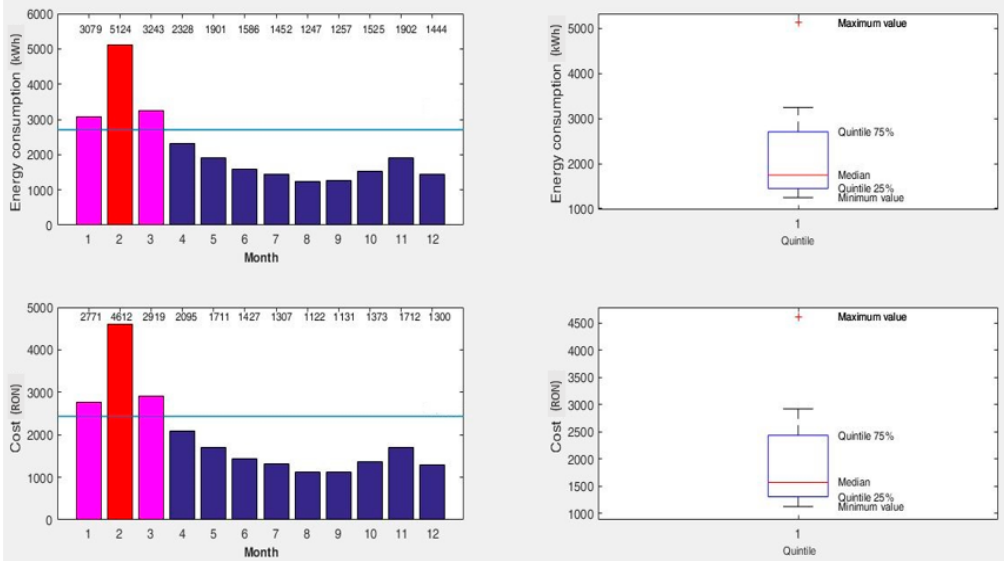
Figure 9. The boxplot of the monthly energy consumption from 2018.